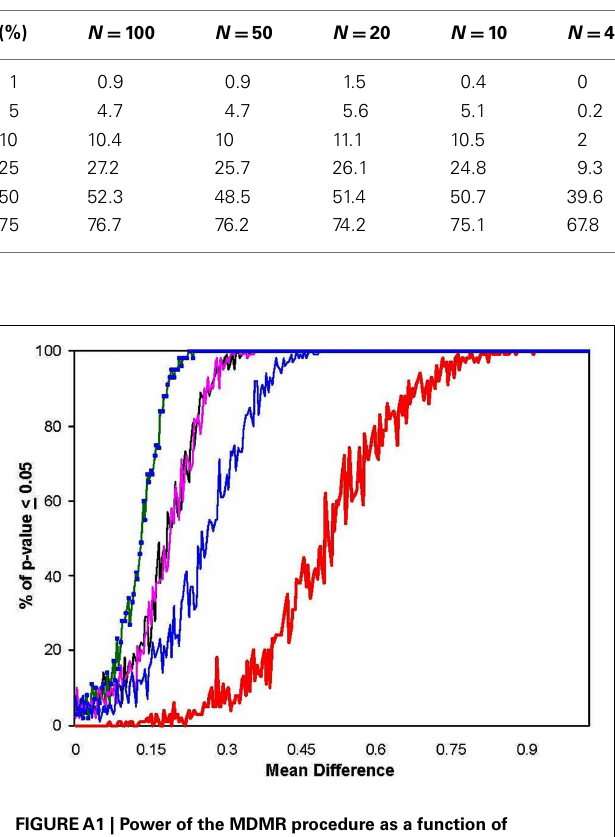
TableA2 | Level accuracy of permutations as a function of decreasing sample size over 1000 Simulations for bimodal distribution.